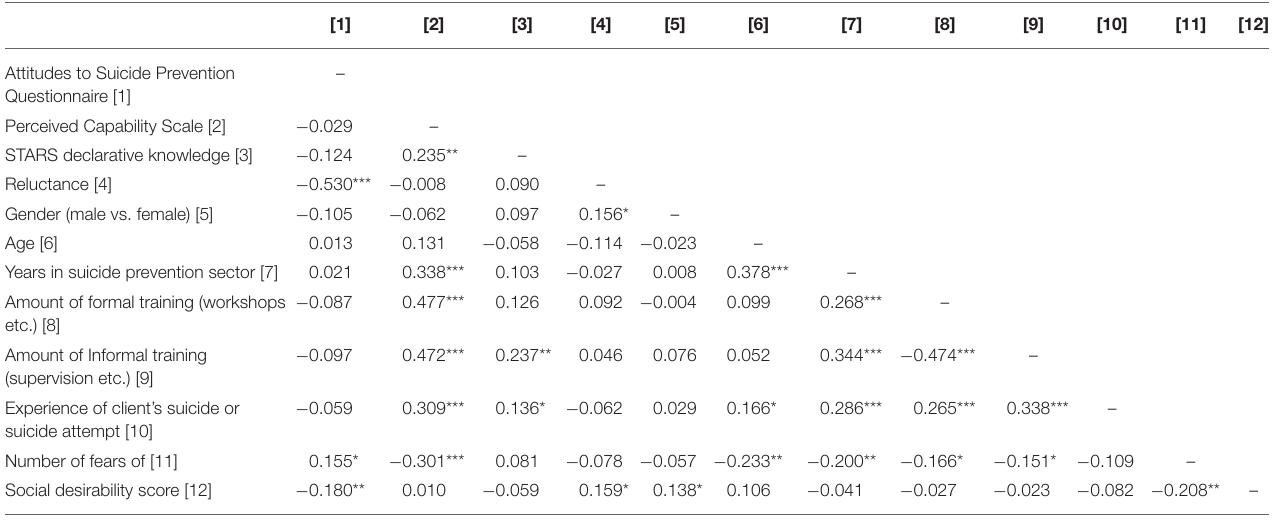
TABLE 3 | Correlations of variables included at baseline.